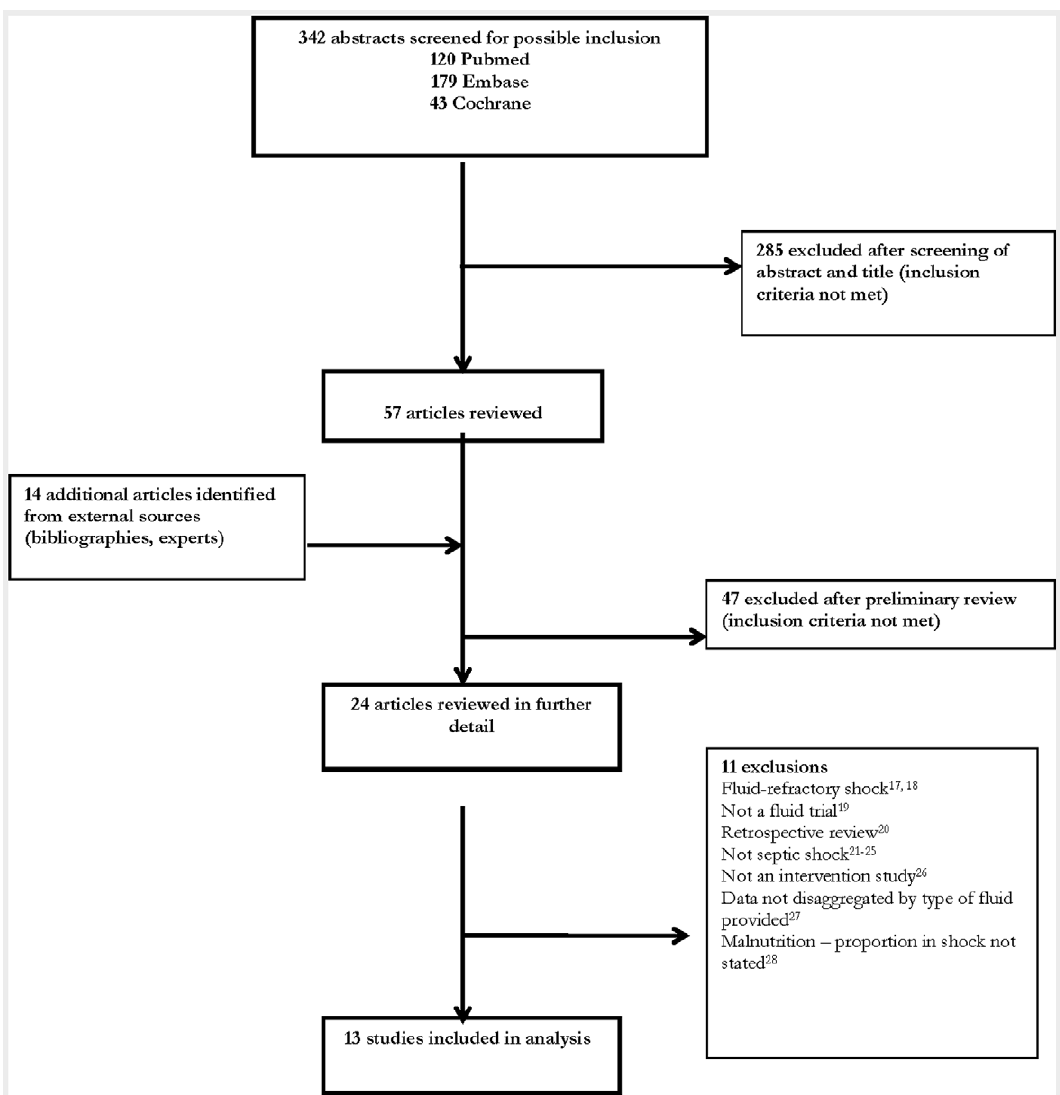
Figure 1. Study inclusions and exclusions.